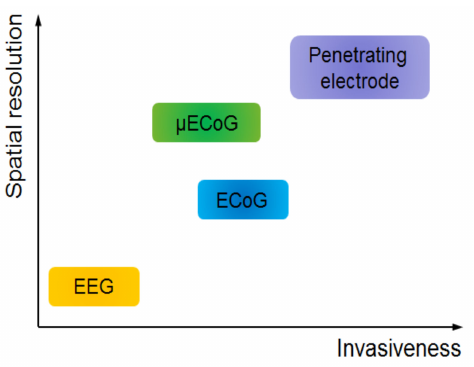
Figure 2. Spatial resolution versus invasiveness for various types of neural electrodes. Micro-ECoG has a balanced spatial resolution and